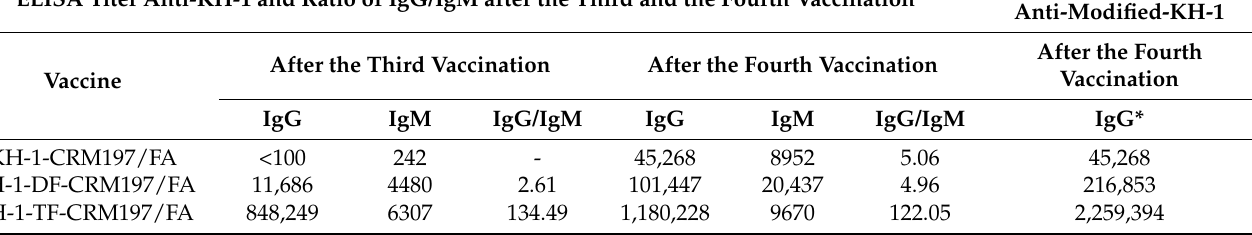
The IgG subtypes in antisera after the third and fourth vaccinations were also detected with ELISA (Figure 3). Immunized with Freund’s adjuvant, KH-1-TF-CRM197 elicited significantly more anti-KH-1 IgG1, IgG2a, IgG2b, and IgG3 antibodies than the unmodified KH-1-KLH. These results indicated that a mixed Th1/Th2 response was elicited by KH- 1-TF-CRM197 because IgG1 antibodies are usually generated via the Th2 response, while activated Th1 cells may generate a prominent IgG2a response [37]. Table 2. Titers of the antibodies elicited by vaccines.